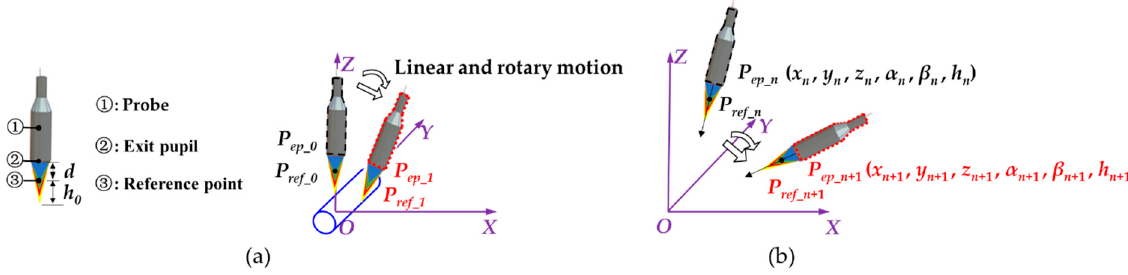
Figure 2. Schematic diagrams for coordinates recursion: ( a ) calculate the first point coordinates; ( b ) calculate the n + 1th point coordinates.